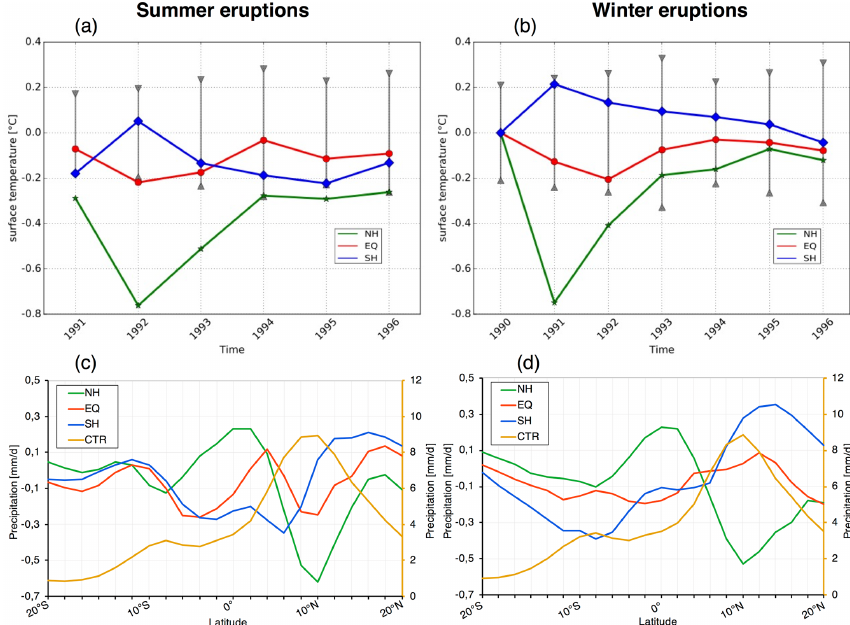
Figure 6. Difference of JJA mean temperature ( ◦ C) anomaly between the Northern and the Southern Hemisphere after the summer eruptions (a) and the winter eruptions (b) , and the position of the ITCZ in 1992 (c) and 1991 (d) indicated by the JJA mean zonal mean precipitation (mmd − 1 ) anomaly between 20 ◦ N and 20 ◦ S. The yellow line (right axis) in (c) and (d) indicates the position of the ITCZ for the control runs, which is calculated with raw precipitation data. The grey bar in (a) and (b) indicates the 2 standard deviation of the control